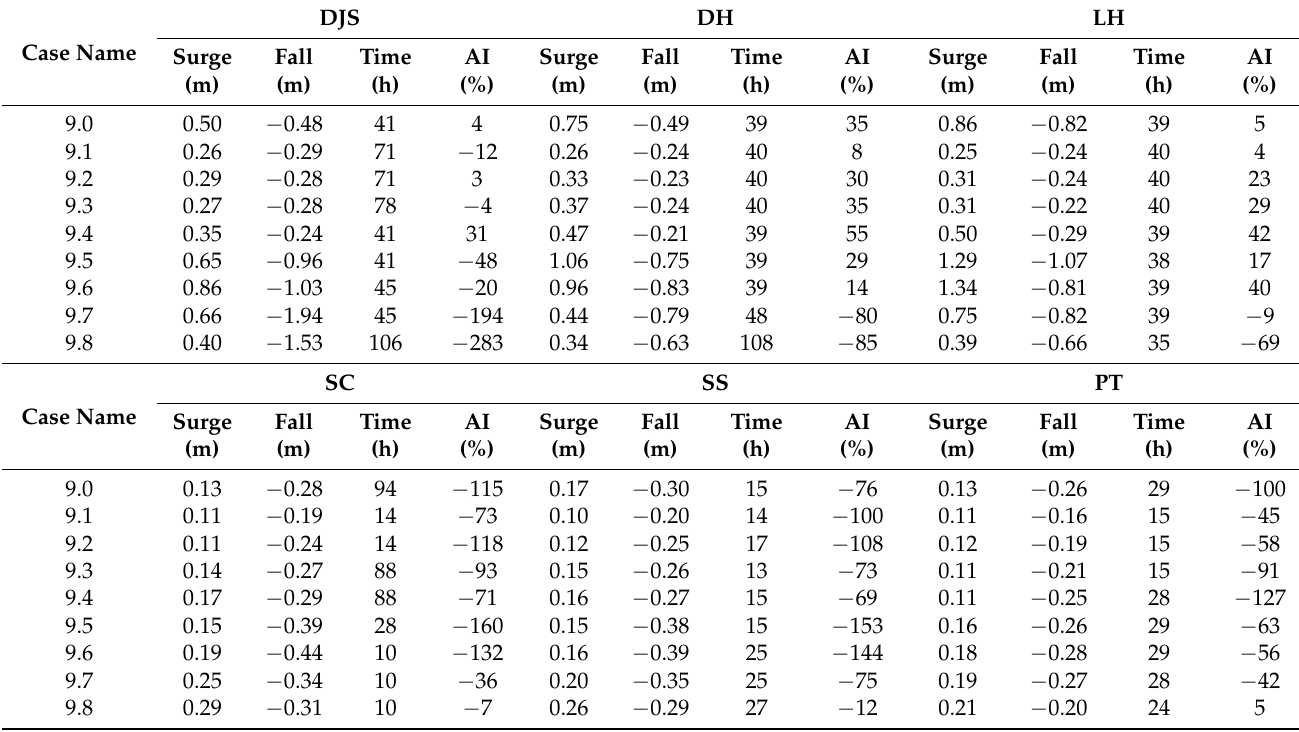
Figure 15. The time series of surge elevations with eight hypothetical paths at ( a ) DJS, ( b ) DH, ( c ) LH, ( d ) SC, ( e ) SS, and ( f ) PT station. Table 7. The model results of surge, fall, time, and the value of AI in different paths at six stations. Surge (m): Surge max ; fall (m): Fall max ; time: occurrence time of surge reaches the peak (from a cold start); AI: asymmetry